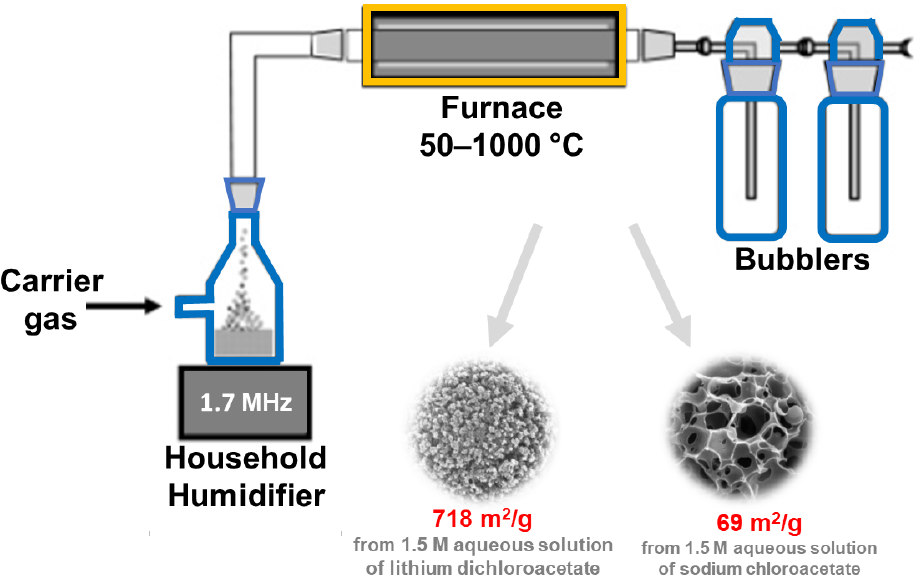
Figure 9. Schematic illustration of ultrasonic spray pyrolysis apparatus, and SEM images of exem- plary carbons obtained using this technique. Reproduced with permission from ref. [84]. Copyright 2007, American Chemical Society. Table 3. Porous carbons obtained via sonochemical-assisted synthesis.